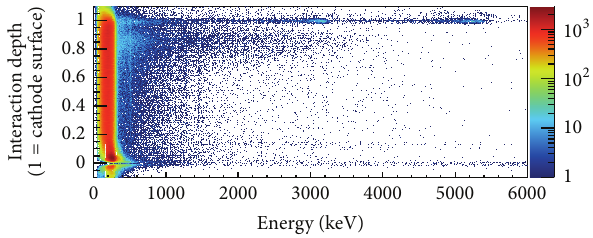
Figure 4: Distribution of events in interaction depth and energy from 82.3 kg ⋅ days of low-background data. Two high energy regions on the cathode surface are identified as alpha contaminants. Three gamma lines (vertical) are also visible. The region below 400 keV is dominated by the 𝛽 -decay of 113 Cd (half-life 8 × 10 15 years). At low depths well-understood detector distortions and reconstruction artifacts can be